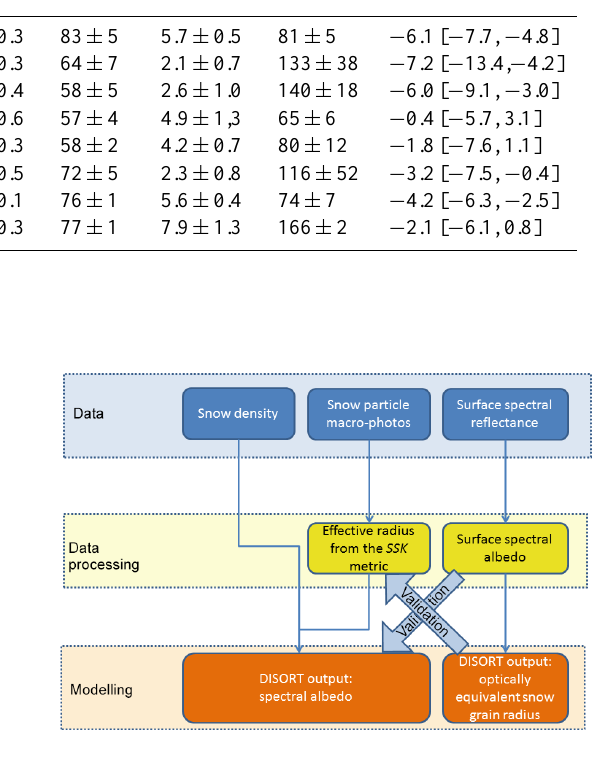
Figure 1. Work flow